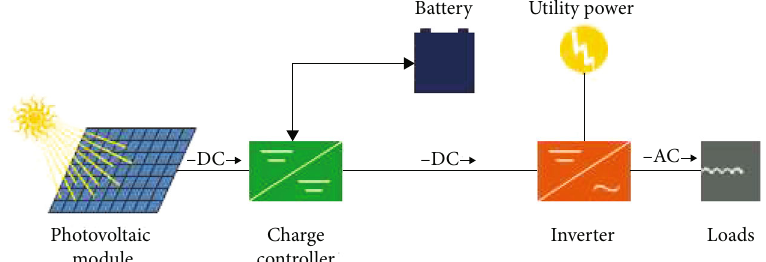
Figure 1: Grid-tied solar system